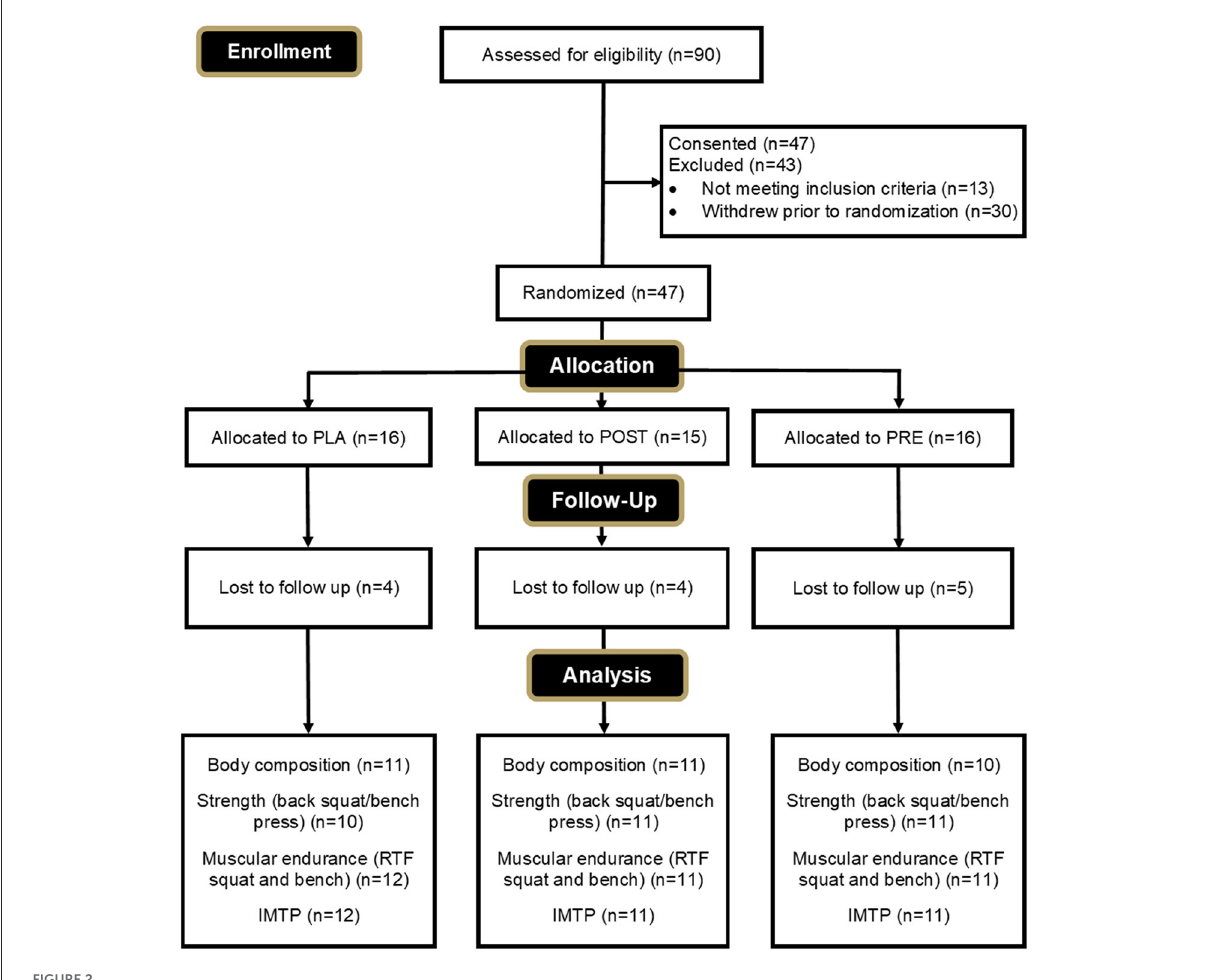
FIGURE2 CONSORT